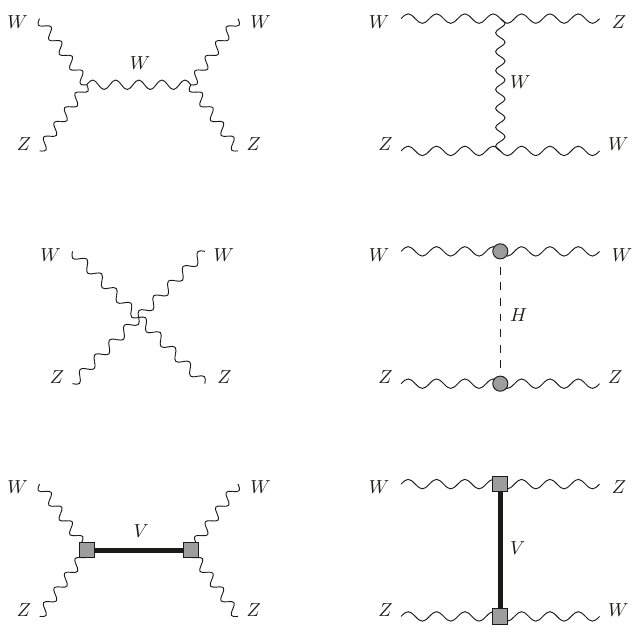
Figure 23 . Feynman diagrams that contribute to the A ( WZ IAM-MC and in the unitary gauge. Gray circles represent vertices that are sensitive to the chiral parameter a . Gray squares show vertices with contributions from